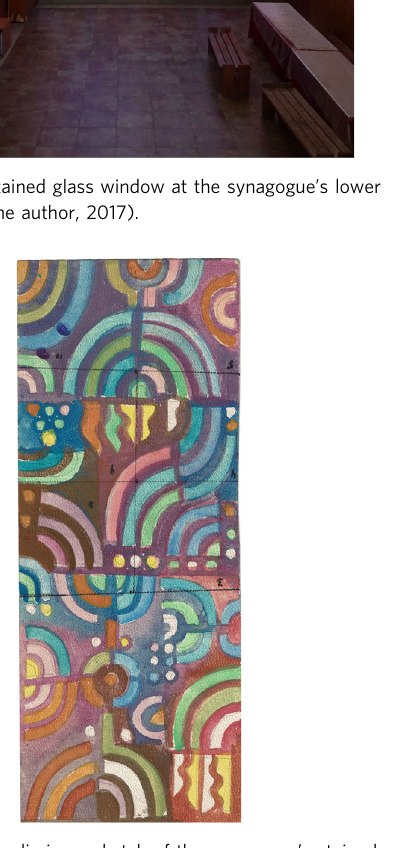
Fig. 10 Ruth Zarfati, preliminary sketch of the synagogue ’ s stained glass window, undated, 11 × 28 cm (courtesy of Zarfati collection).